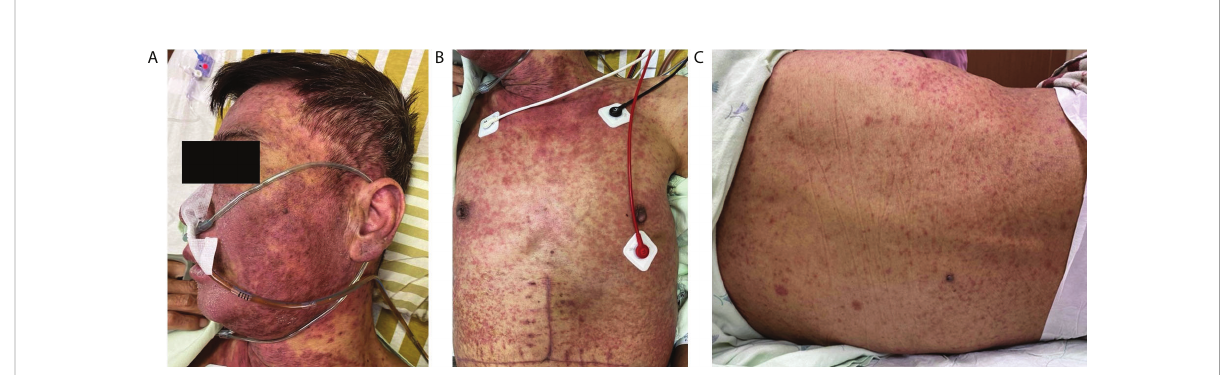
FIGURE 1 Skin manifestations. (A) Diffuse erythematous – violaceous maculopapular exanthems on the face. (B) Stevens – Johnson syndrome-like atypical fl at targets on the neck. (C) Erythematous folliculocentric papules on the